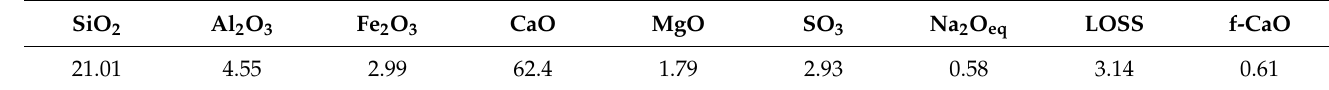
Table 1. Chemical composition of cement